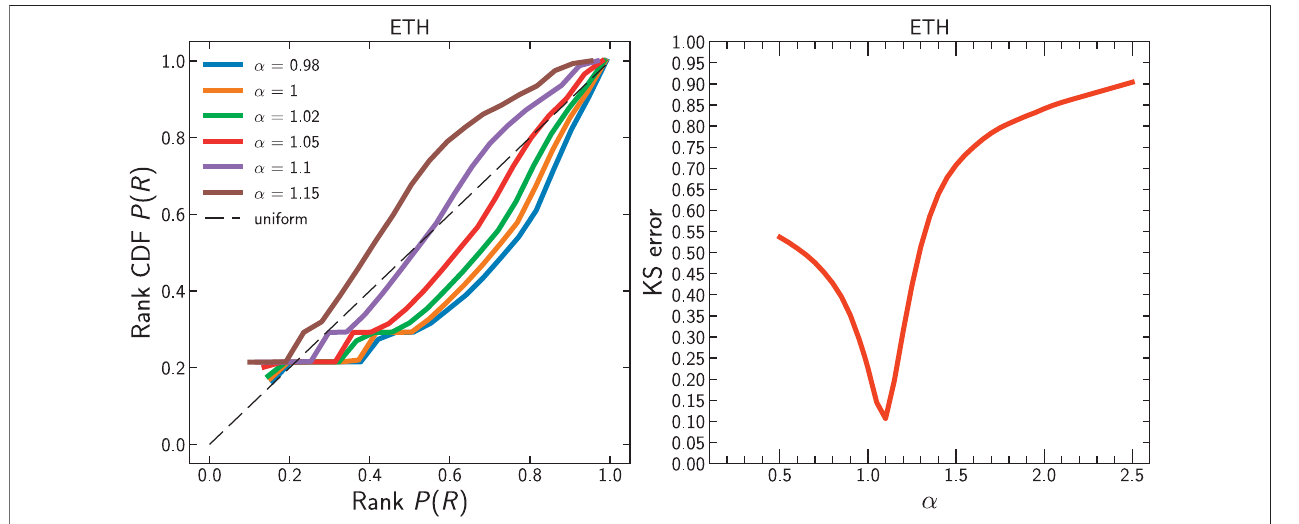
FIGURE 6 | ETH. Rank function for different α . KS distance. α value minimising error.